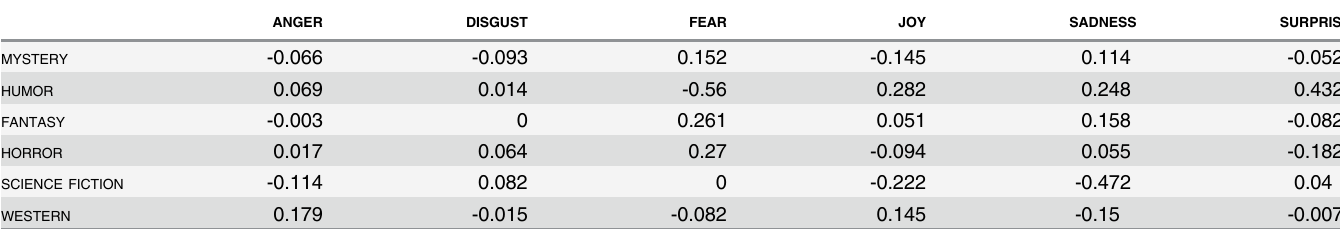
Table 3. Emotion importance